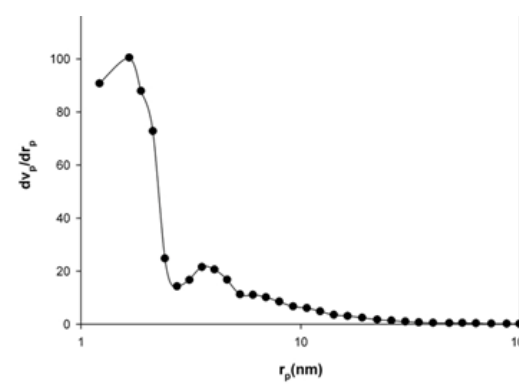
Fig. 4. TEM (a) and SEM images of MWCNT (b) and MWCNT-COOH (c).